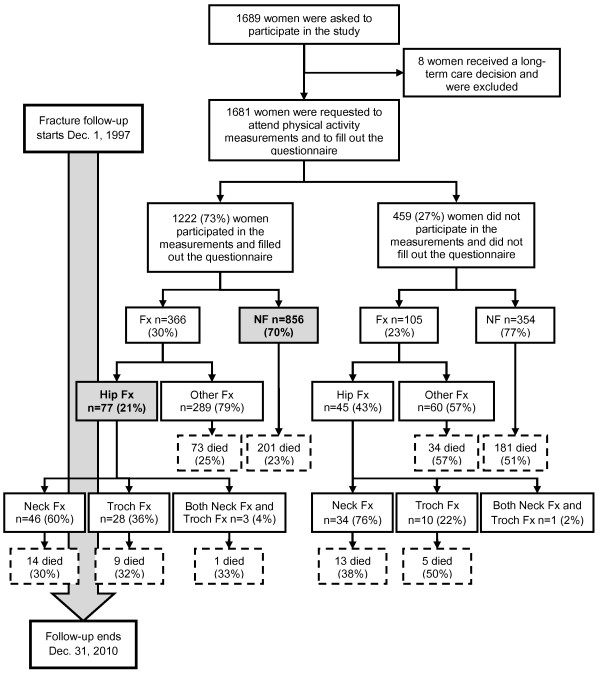
Participant flow. Number of women with and without fractures, as well as deaths, in the study population. NF = subjects with no fractures, Fx = subjects with any fracture, Other Fx = subjects with any fracture other than hip fractures, Hip Fx = subjects with at least one hip fracture, Neck Fx = subjects with a cervical fracture, Troch Fx = subjects with a trochanteric fracture. The subjects included to the final analysis have been highlighted.